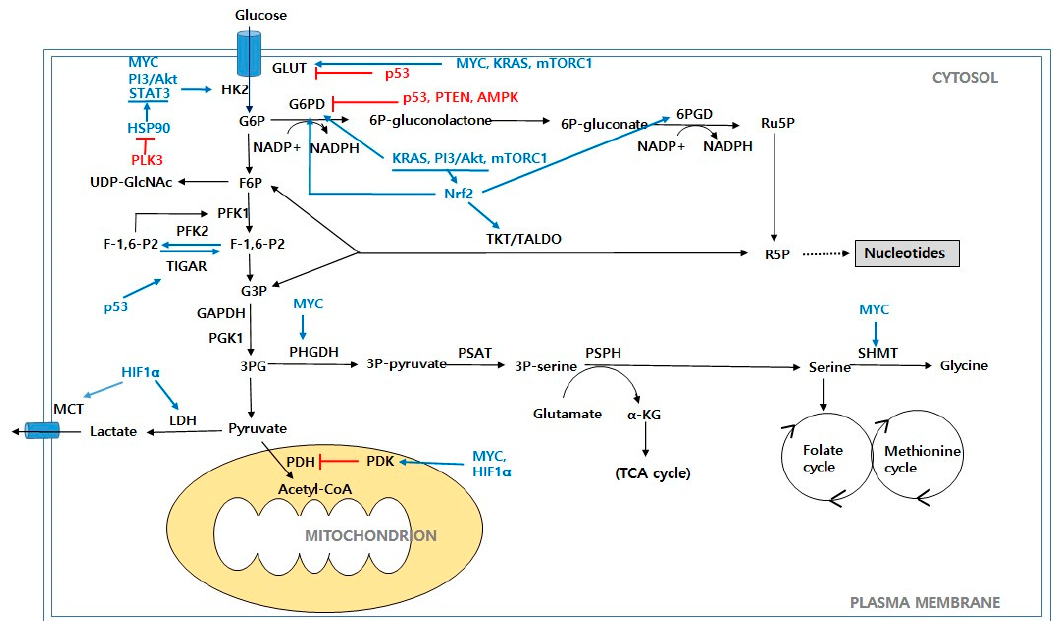
Figure 1. Glucose metabolism in cancer cells. Schematic representation of main metabolic pathways that contribute to production of biomass precursors, including glycolysis, PPP, HBP, and serine bi-